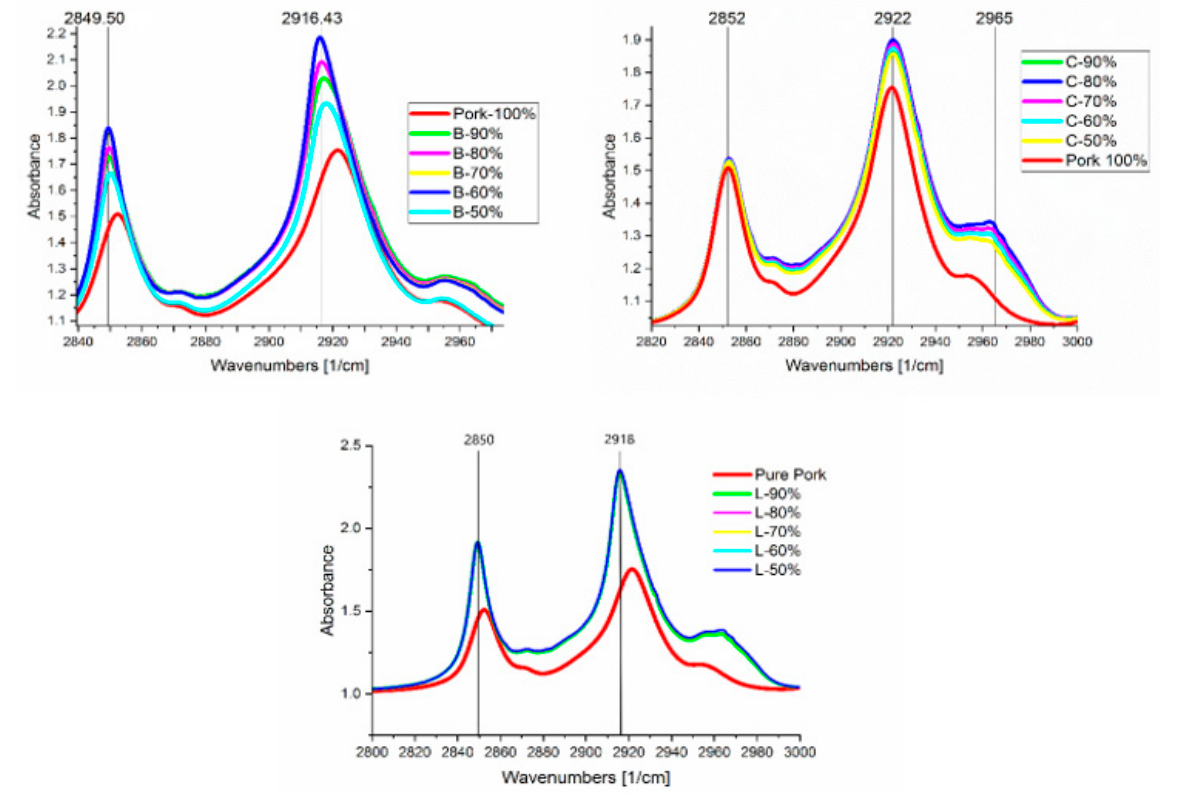
Figure 4. Peaks zoomed-in for adulterated samples overlapped with pure pork, for beef (B-50% to B-90%), lamb (L-50% to L-90%), and chicken (C-50% to C-90%), with associated adulteration ratio and associated peaks for RoD(a) and RoD(b). Table 5. Absorbance values and percentage difference with respect to lard for adulterated samples of beef, lamb, and chicken in the region of RoD(b) at the highly significant region of 2800–3000 cm − 1